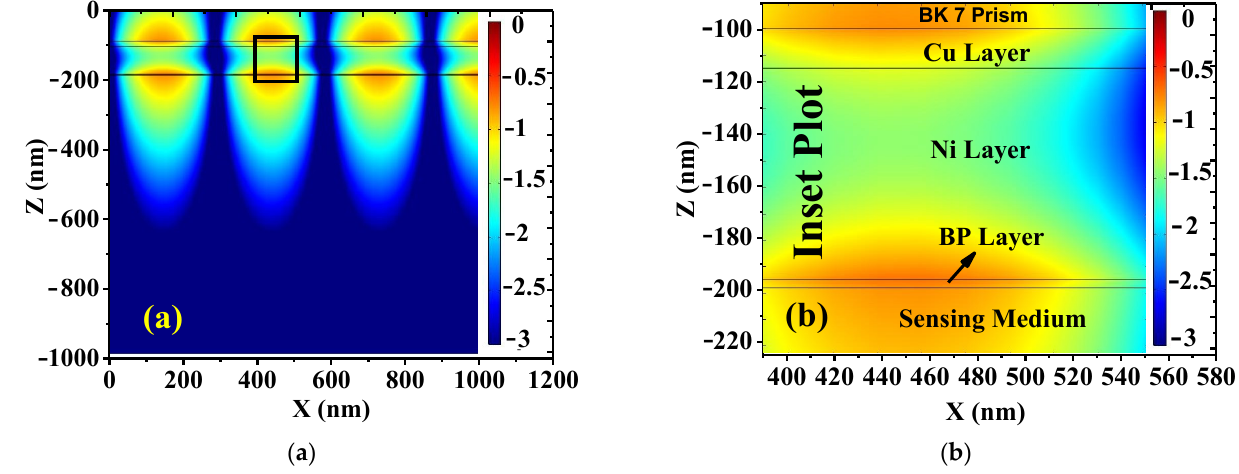
Figure 8. Proposed sensor: ( a ) SPs field distribution; ( b ) inset plot (an enlarged view).